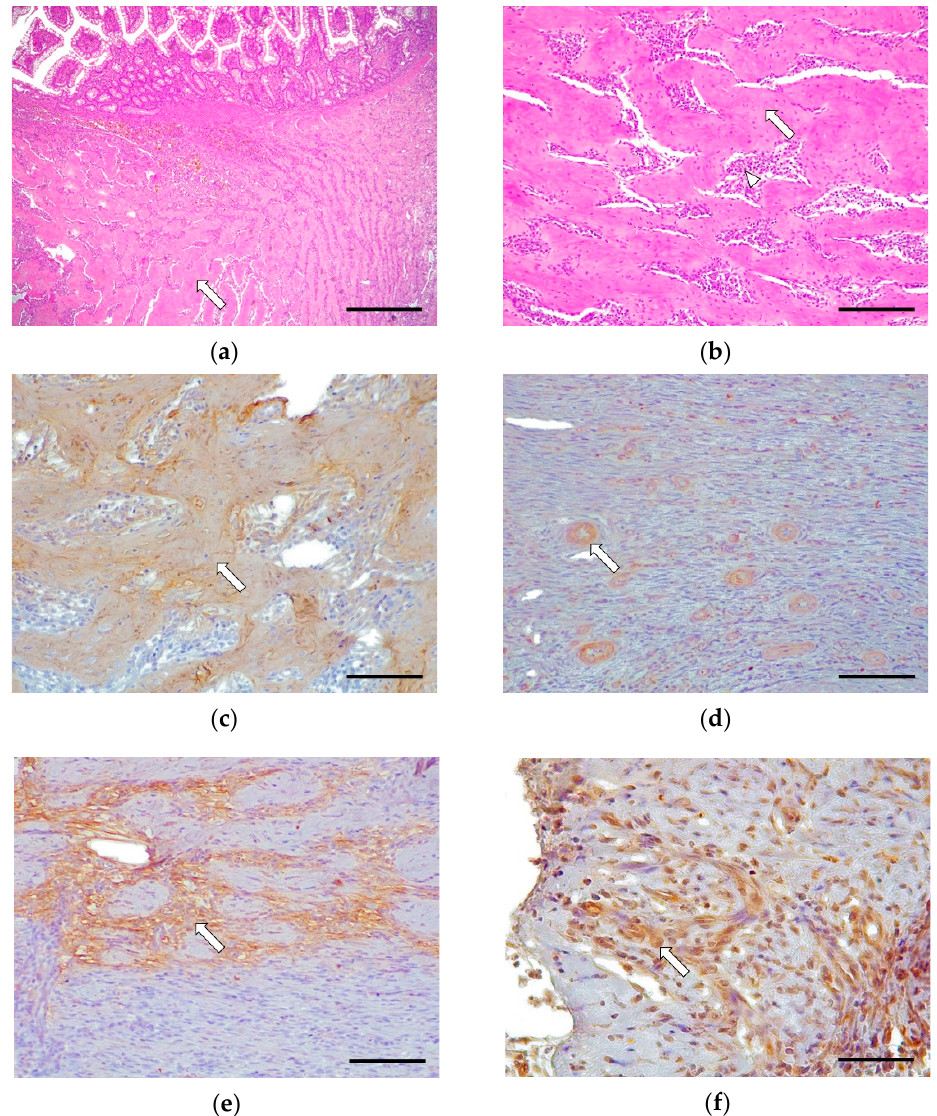
Figure 3. Feline Eosinophilic Gastrointestinal Sclerosing Fibroplasia (Grade III). Cat, du4odenum, case No. 16. ( a ). Dense collagen bands (arrow) occupying the lamina propria, submucosa, and muscular layer. Hematoxylin–eosin. Scale bar: 400 µm. ( b ) These bands (arrow) are surrounded by a mild to moderate number of fibroblasts and eosinophils (arrowhead). Hematoxylin–eosin. Scale bar: 100 µm. ( c ) Intense fibrillar collagen I immunoexpression in the dense bands (arrow) in the submucosa, muscular, and serosa layers. Rabbit polyclonal anti-collagen I. Scale bar: 200 µm. ( d ) Negative immunoexpression against collagen III is observed at the fibrotic bands, immunoexpressed only at the perivascular level (arrow) without affecting the sclerosing connective tissue. Rabbit polyclonal anti-collagen III. Scale bar: 200 µm. ( e ). Intense fibronectin immunoexpression in fibroblasts (arrow) in the submucosa and muscular layers. Rabbit polyclonal anti-fibronectin. Scale bar: 200 µm. ( f ). Moderate cytoplasmic TGF- β 1 immunoexpression in fibroblasts and mononuclear cells (arrow), be- tween the collagen bands as well as in the submucosa and muscularis. Rabbit polyclonal anti-TGF- β 1. Scale bar: 100 µm. − − +++ ++ − II 11 Lp, Sb − − − − − − +++ ++ − II